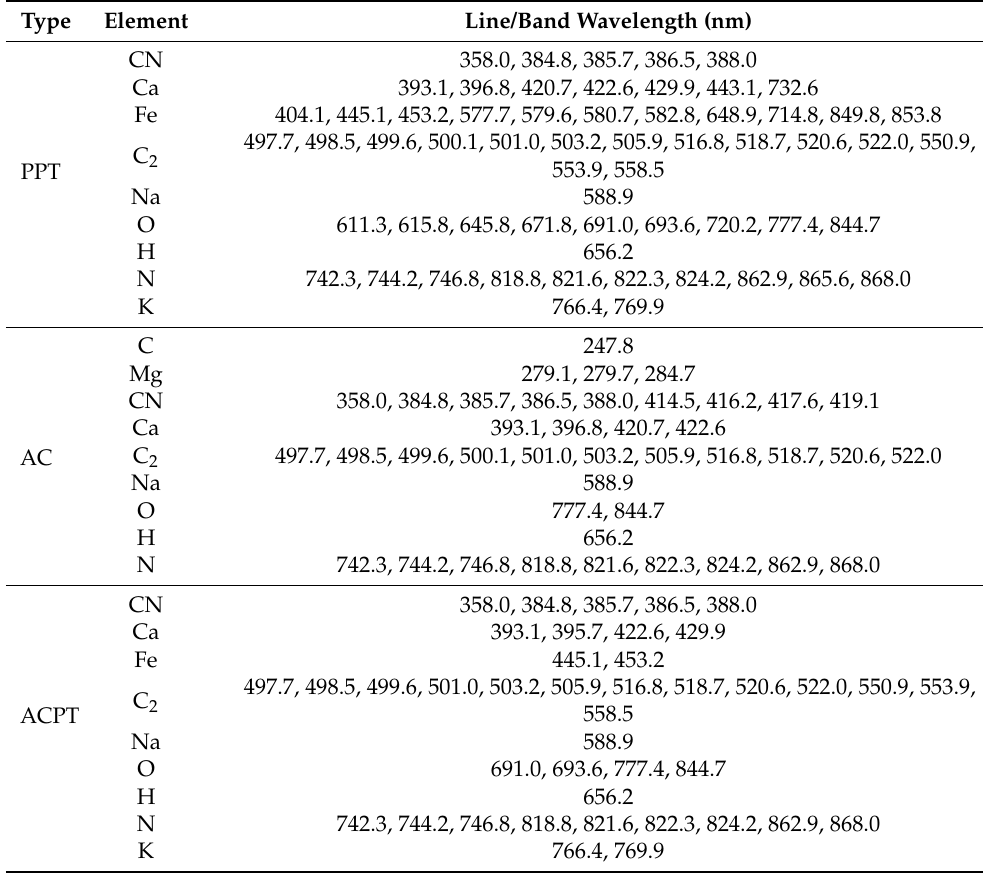
Table 2. Corresponding wavelengths of the elements or molecular bands in the penicillin LIBS